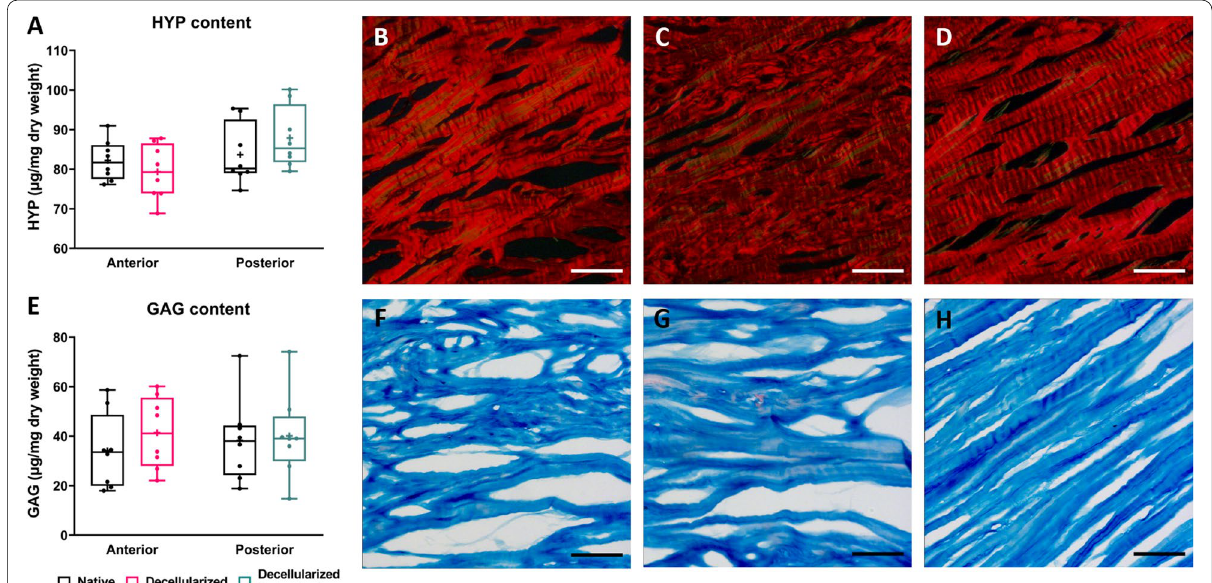
Fig. 4 Native meniscal biochemical composition and tissue structure are maintained after both decellularization and sterilization. A Hydroxyproline content. B - D Histological sections of native ( B ), decellularized ( C ), and decellularized E Glycosaminoglycan content. F - H Histological sections of native ( F ), decellularized ( G ), and decellularized with Alcian Blue. Box plots show all data points with median, maximum value, minimum value, and 25th and 75th percentiles. Scale bar represents 100